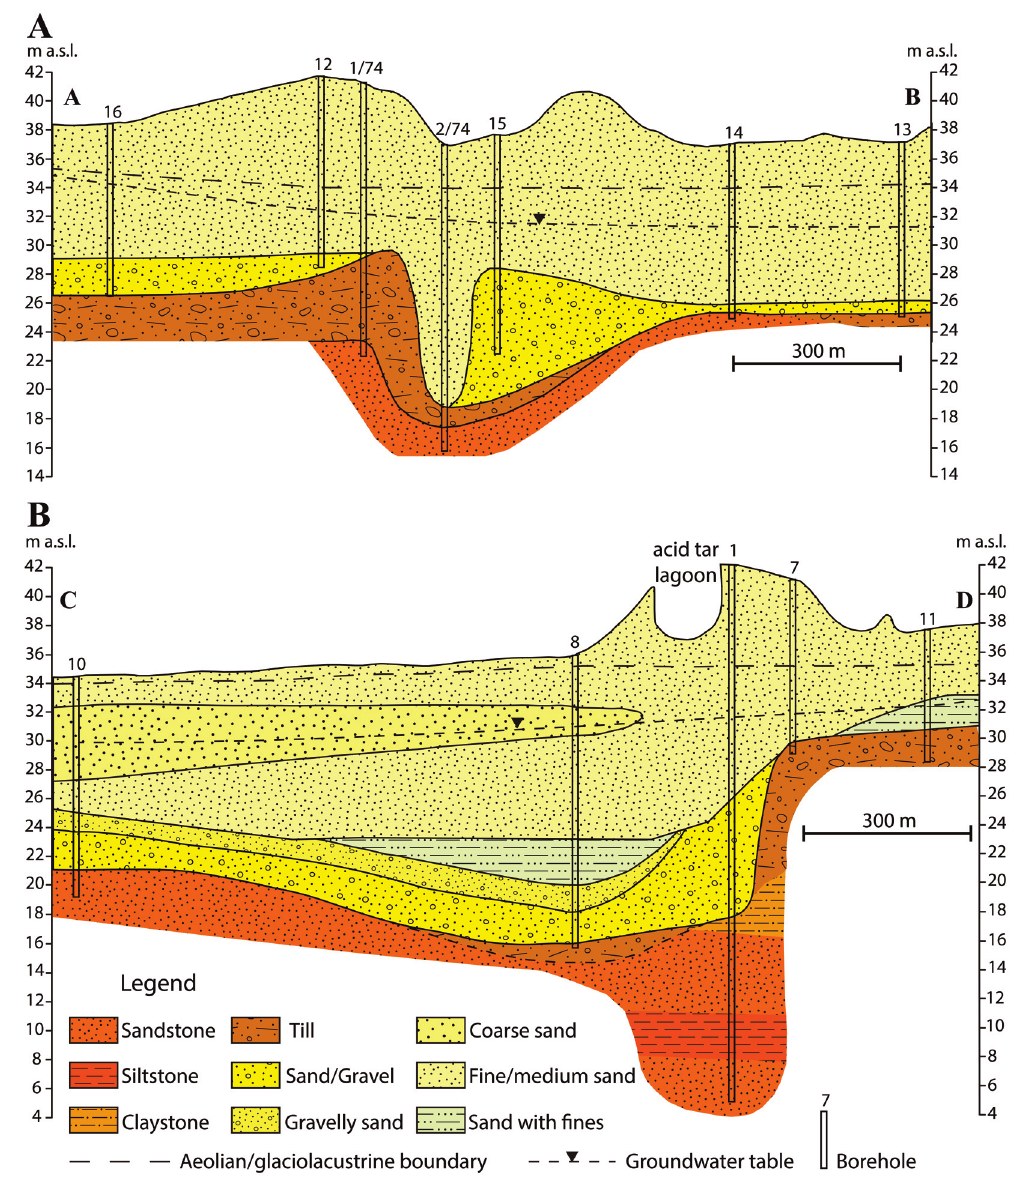
Fig. 2. Geological cross-section of the study area (after Berzina & Samushenkov 1977). A , cross-section A–B; B , cross-section C–D. For location see Fig.